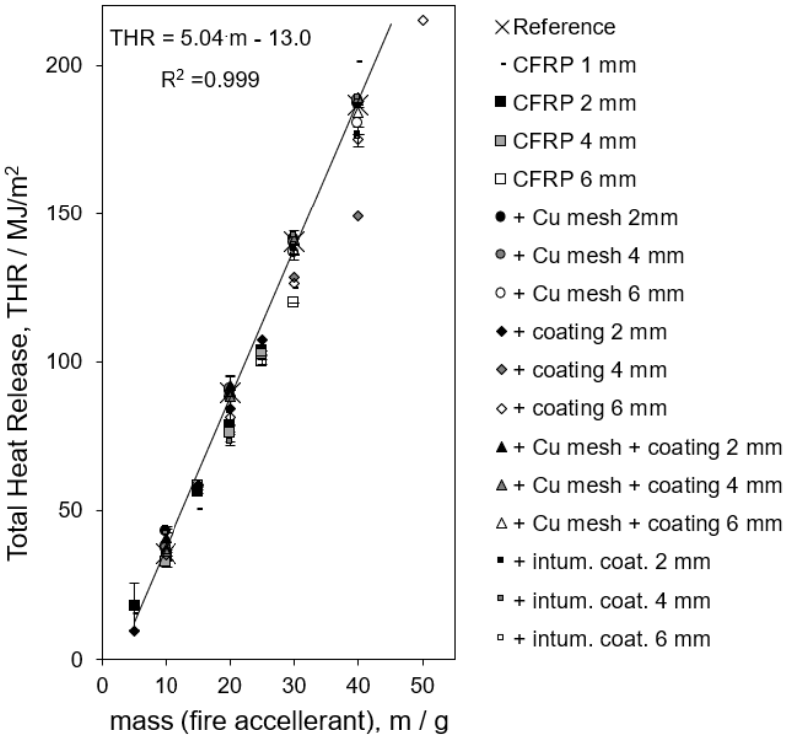
Figure 6. Total heat release (THR) for various amounts of fire accelerants on all types of horizon- tally aligned 8552/IM7 samples (Line corresponds to reference material: fire accelerant on steel panel).